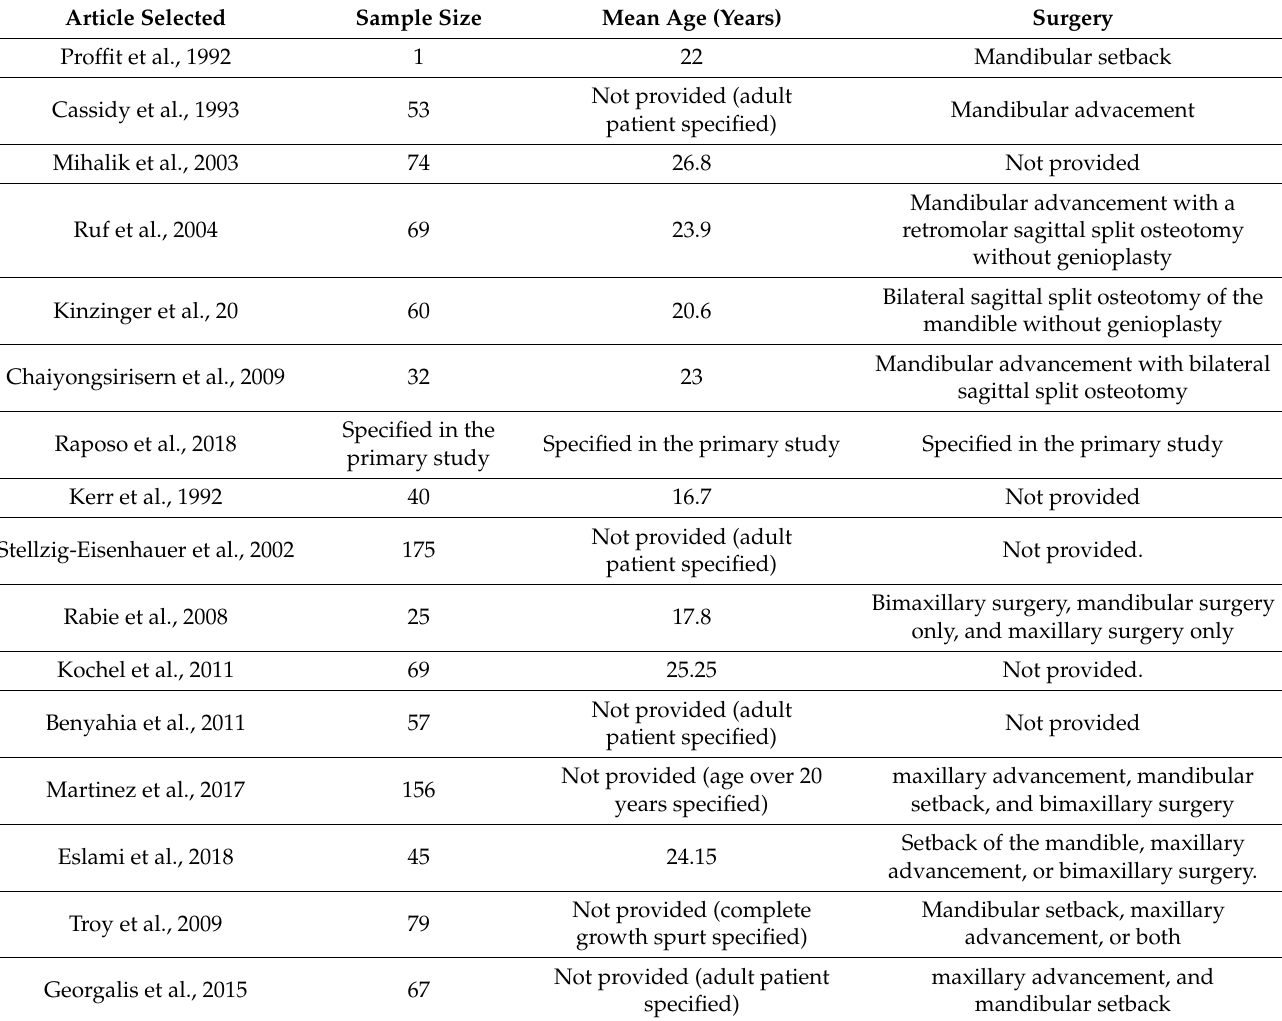
Table 2. Sample size, mean age and surgical procedure considered in each